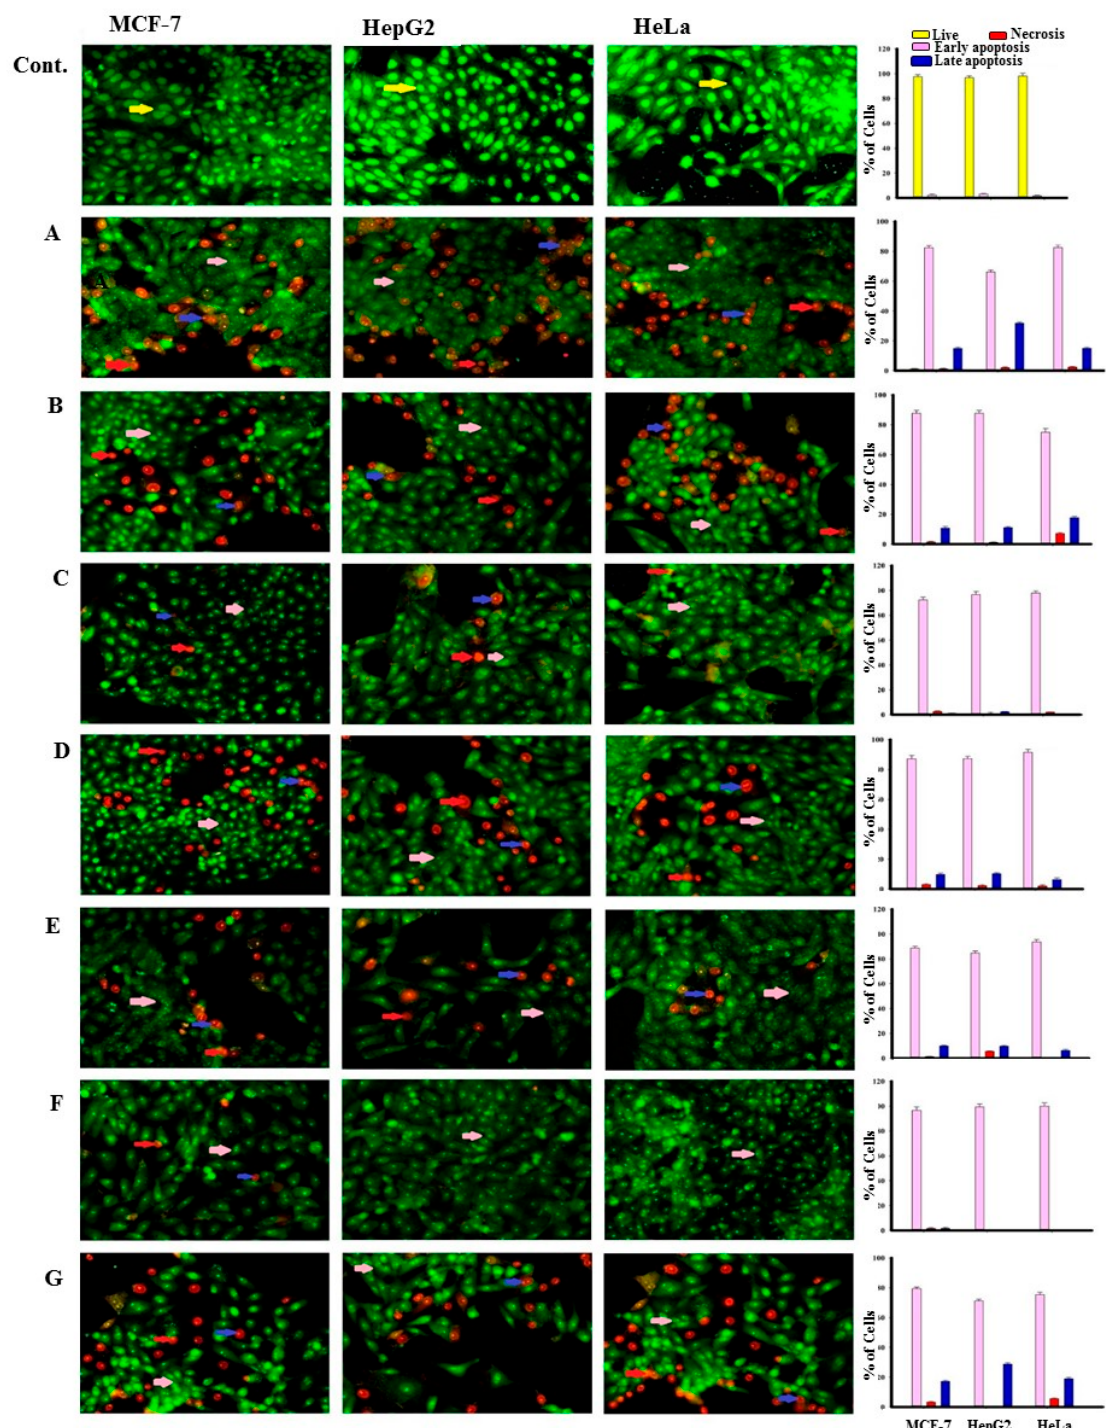
Figure 2. Morphological and nuclear changes using acridine orange (AO) and ethidium bromide (EB) staining, that were evaluated by the effect of compounds treatment on apoptosis of MCF-7, HepG2, and HeLa human tumor cells after 48 h treatment, induced various nuclear changes such as chromatin fragmentation and condensation and nuclei condensation at 200×. Yellow arrows indicate live cells, pink arrows indicate early apoptotic, red arrows indicate necrotic and blue arrows indicate late apoptotic cells. Cells were treated with IC 50 of compounds 1 ( B ), 2 ( C ), 3 ( D ), 4 ( E ), 5 ( F ), 6 ( E ), and 7 ( G ) 48 h. The control ( A ) was similarly processed. The ( A – G ) were stained with acridine orange-ethidium bromide. ( Top ): The control ( A ) was processed in the same manner as the compounds 1 – 7 for 48 h.